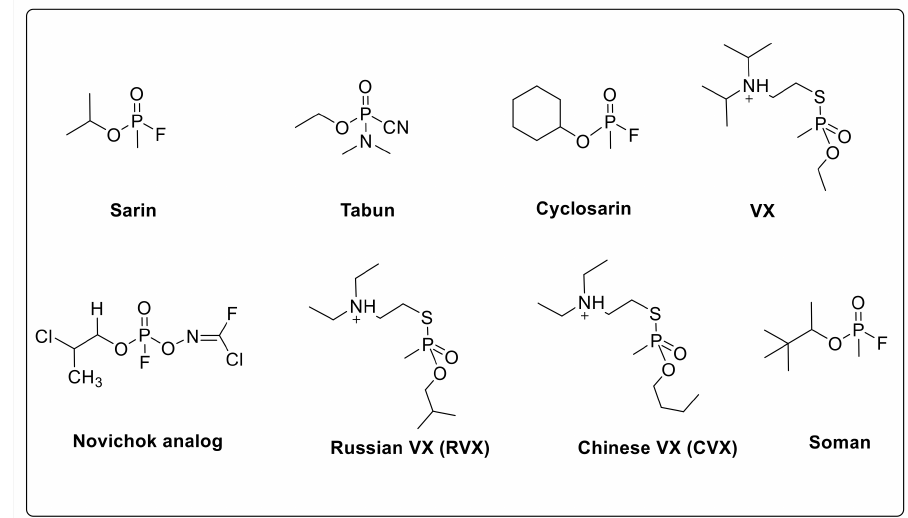
Figure 5. Chemical structures of selected organophosphate agents.